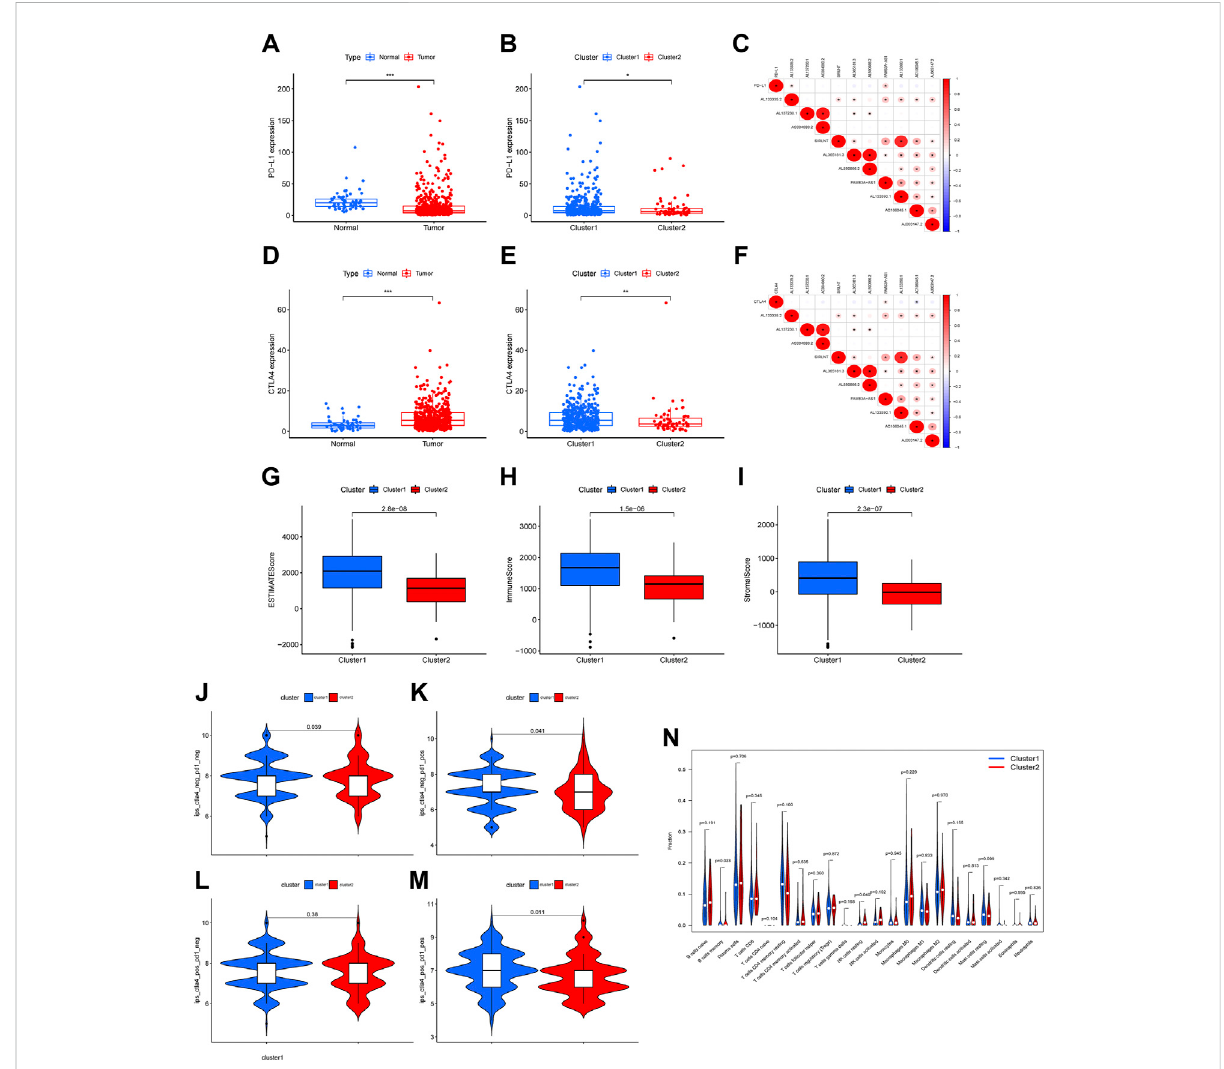
FIGURE 2 Immunoassay of two clusters. The expression level of PD-L1 between normal and tumor tissues (A) , between cluster 1 and cluster 2 (B) . The correlationbetweenPD-L1expressionandexpressionof10NETs-associatedlncRNA (C) .Theexpressionlevel ofCTLA4betweennormalandtumor tissues (D) , between cluster 1 and cluster 2 (E) . The correlation between CTLA4 expression and expression of 10 NETs-associated lncRNAs (F) . The difference in ESTIMATE score, immune score and stromal score between cluster 1 and cluster 2 (G – I) . Immunephenoscores (IPS) analysis (J – M) . The abundance of immune in fi ltration cells in cluster 1 and cluster 2 (N) (* p < 0.05, ** p < 0.01, *** p <